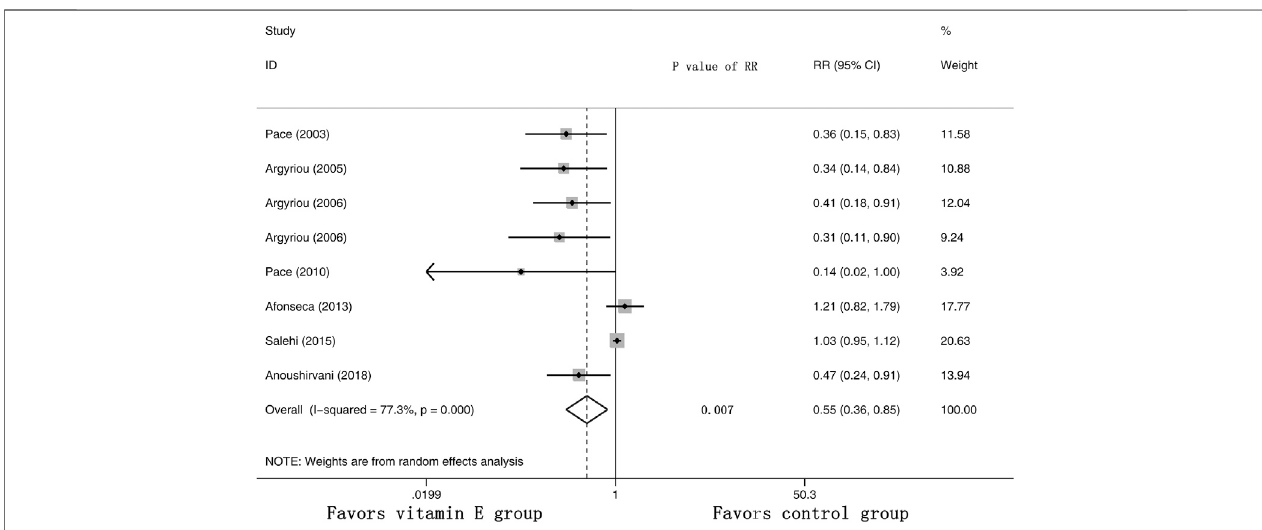
FIGURE3| Forestplotoftheincidenceofall-gradeCIPNinVEandcontrolgroups.Summaryoftheincidenceofall-gradeCIPNRRbetweenVEandcontrolgroups were calculated using the random effect model. VE, vitamin E; CIPN, chemotherapy-induced peripheral neuropathy; RR, risk ratio; P, p value of the Q test for